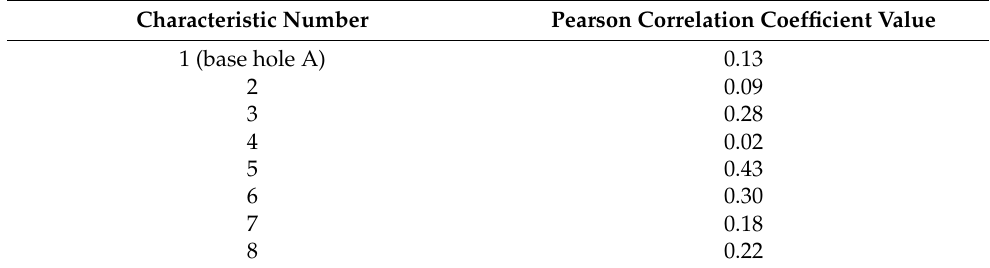
Table 1. Correlation of true positions of bearing seats measured using CNC and CMM. Characteristic